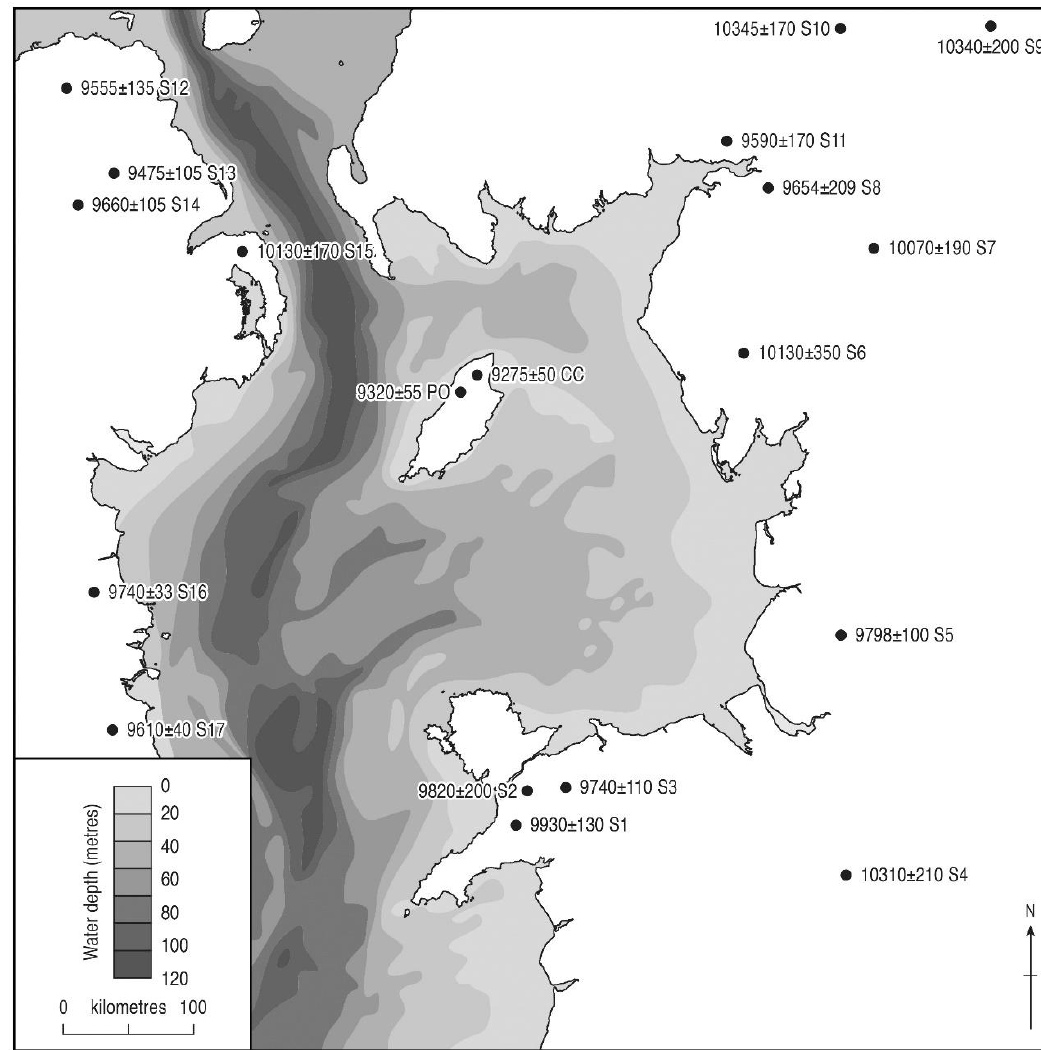
Figure 11. Radiocarbon ages for the Betula rise in the northern Irish Sea region. For sources and date calibration ranges see Supplementary File S1.